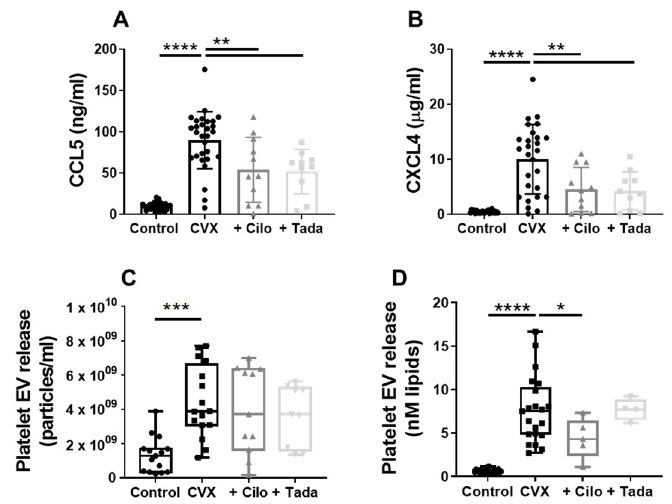
Figure 5. Effect of PDE3A and -5 inhibition on convulxin-induced chemokine and extracellular vesicle release by platelets. Washed platelets were stimulated with convulxin (100 ng/mL) without or with cilostazol (5 μ M) or tadalafil (10 nM), and the release of chemokines CCL5 ( A ) and CXCL4 ( B ), and of total ( C ) and procoagulant ( D ) platelet extracellular vesicle (EV) was measured. ( A , B ) Mean ± S.D., n = 27–29 (control, CVX) or 10–11 (cilo, tada). ( C , D ) Interquartile range, n = 15–16 (control, CVX; NTA), 9–11 (cilo, tada; NTA), 21–22 (control, CVX; PTase), 4–5 (cilo, tada; PTase), * p < 0.05, ** p < 0.01, *** p < 0.001, **** p < 0.0001. Statistics: ordinary one-way ANOVA followed by Dunnett’s ( A , B ) or Holm-Sidak’s ( C , D ) multiple comparisons test. Cilo, cilostazol; CVX, convulxin; NTA, na- noparticle tracking analysis; PTase, prothrombinase; tada, tadalafil.